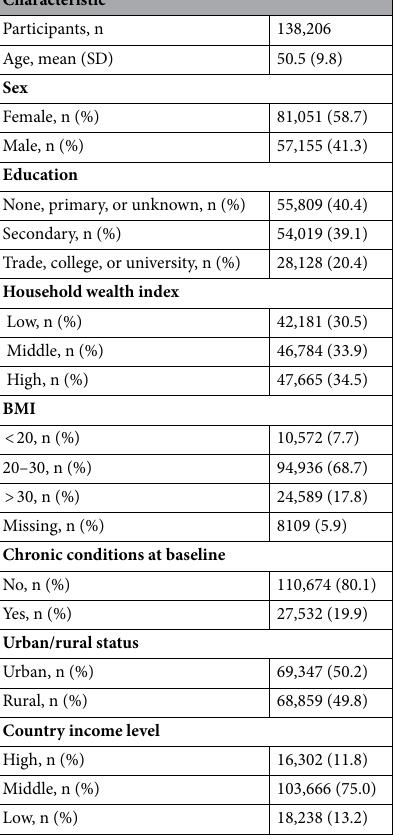
5-year community population density All participants